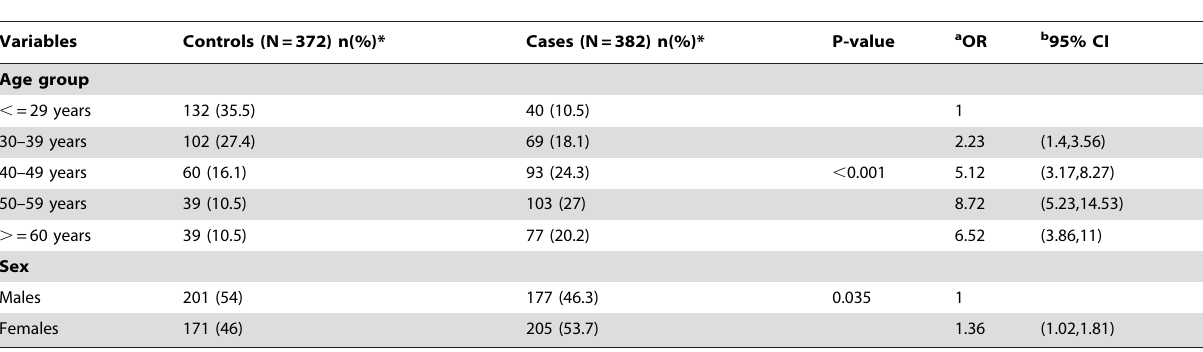
Table 1. Demographic distribution of patients with CVD and controls.